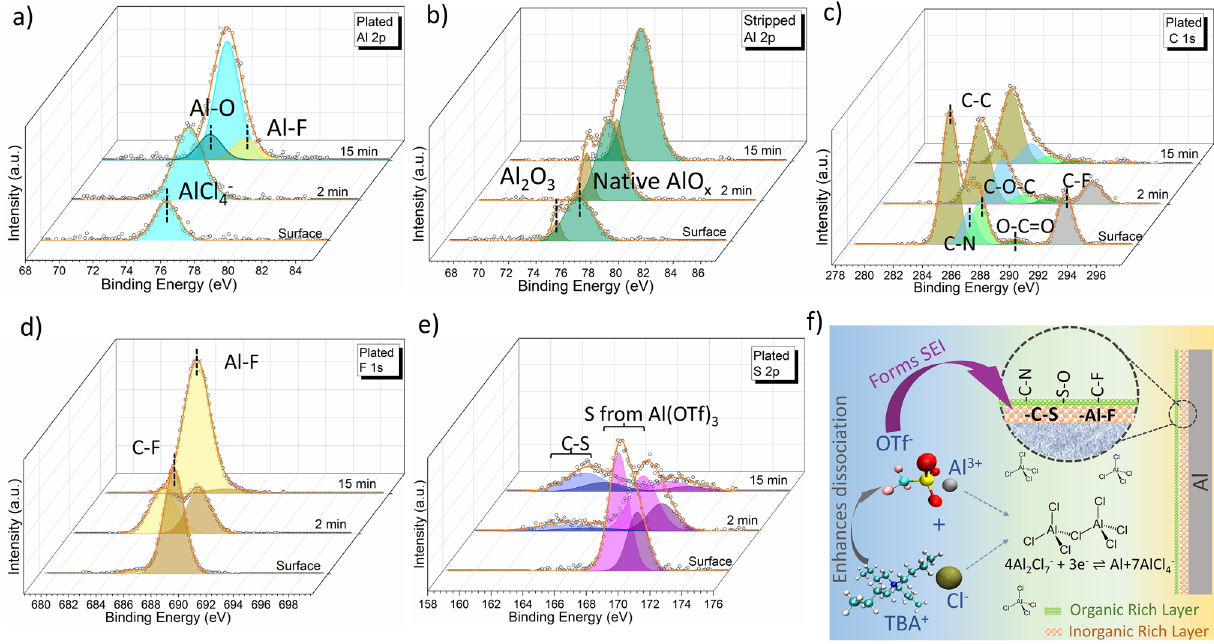
Fig. 5 XPS spectra collected from different depths (top surface, after 2 min of etching and after 15 min of etching) of cycled Al-metal in Al symmetric cell: a Al 2 p , c C 1 s , d F 1 s and e S 2 p region of XPS spectra for the plated Al-metal foil. b Al 2 p region of XPS spectra for the stripped Al-metal foil. f Schematic illustration of the process steps involved in the modification of the electrolyte speciation upon addition of TBAC in the solvent; the process steps involved in the formation of SEI layer; the composition of the SEI